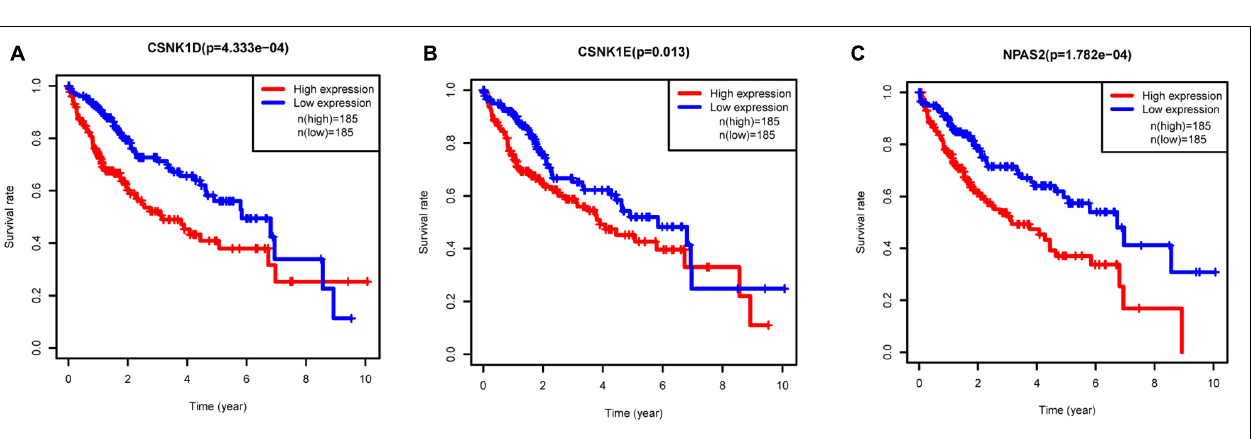
FIGURE 5 | Relationships between three hub gene expression levels and survival rate in LIHC. (A) CSNK1D , (B) CSNK1E , and (C) NPAS2 .